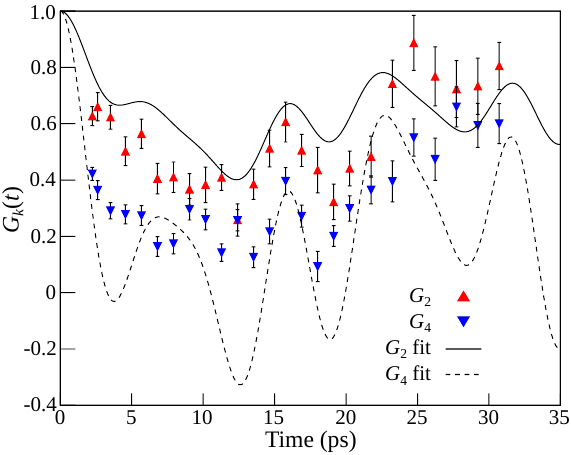
Figure 5. G k vs t plot showing data points obtained by free- fitting G 2 and G 4 to measured angular correlations (as described in Section 2.3), and a superposition of the frequencies shown in Fig. 4 having relative populations of 25% F-like 2 p 3 / 2 , 15% F- like 2 p 1 / 2 , 35% Na-like 3 s 1 / 2 and 25% Na-like 3 p 1 / 2 . For the frequencies shown here, g = 0.55, obtained from producing an optimal fit the values forming the peak at